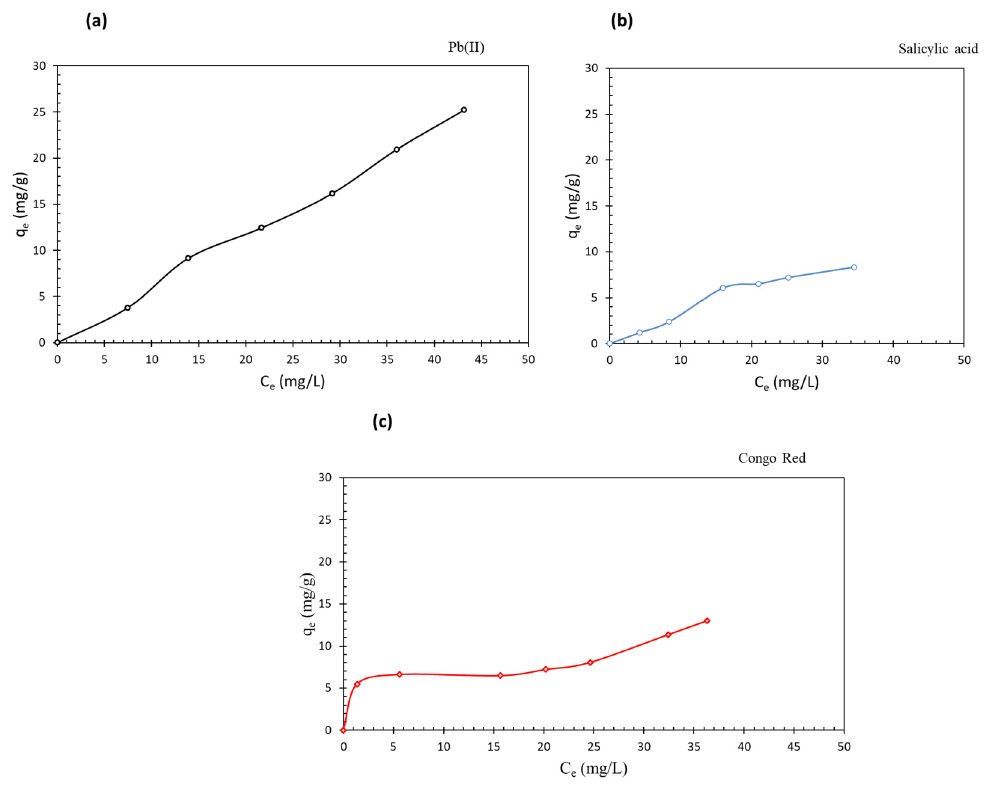
Figure 4. Adsorption isotherms for the three studied contaminants at 25 ± 2 °C and pHs of 5.5 ± 0.1, 4.0 ± 0.3, and 6.1 ± 0.2 for ( a ) Pb(II), ( b ) SA, and ( c ) CR, respectively. Table 4. Isotherm parameters as predicted by Langmuir and Freundlich